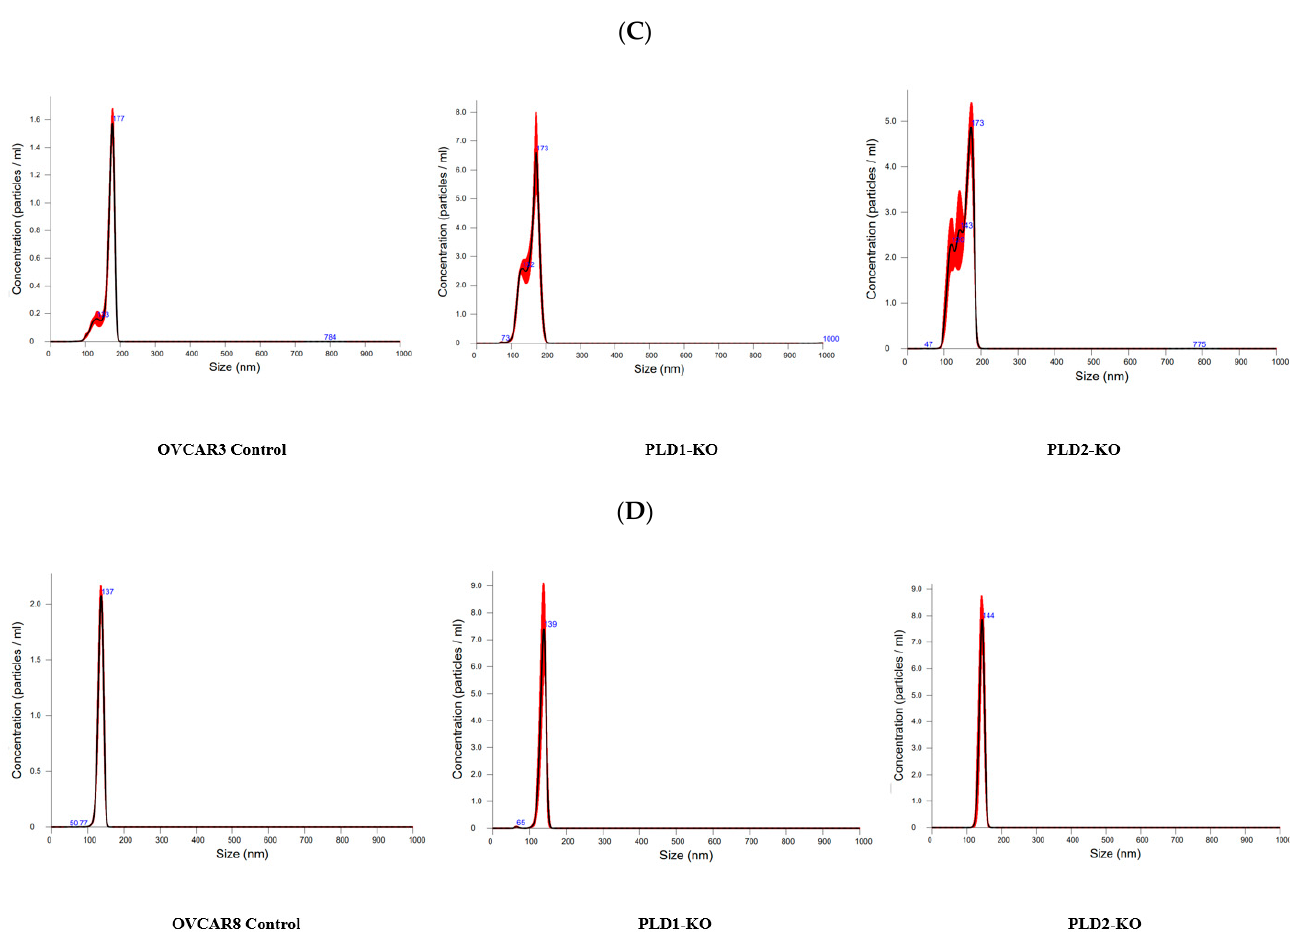
Figure 1. Exosome secretion in OVCAR3 and OVCAR8 control and KO cell lines. ( A ) Western blot demonstration of PLD1/2 CRISPR-Cas9 KO clones. ( B ) Exosomes particles concentration in OVCAR3 and OVCAR8 control and KO cells. Exosome secretion is reduced in PLD1/2-KO cells compared to control in both cell lines (** p < 0.01, n = 3). Error bars represent SEM. ( C , D ) Exosomes quantification using Nanosight NS3000 nanoparticle tracking analysis (NTA). Exosomes derived from all genotypes in the ( C ) OVCAR3 and ( D ) OVCAR8 cell lines were measured, PLD1-KO and PLD2-KO exosome secretion in both cell lines was significantly reduced.